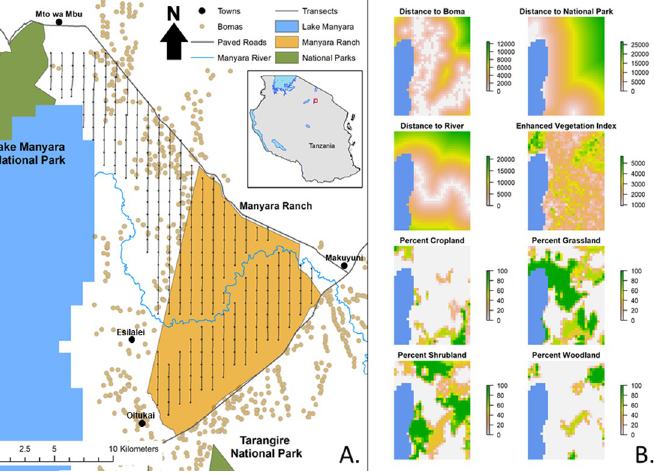
Fig 1. Maps of the study area and environmental predictor variables. (A.) Map of the study area in northern Tanzania (red box in inset map of Tanzania) showing the location of transects in relation to important landscape and management features including human settlements (bomas) [76]. (B.) Environmental predictor variables used to model large mammal habitat suitability. Distance variables are represented in meters.